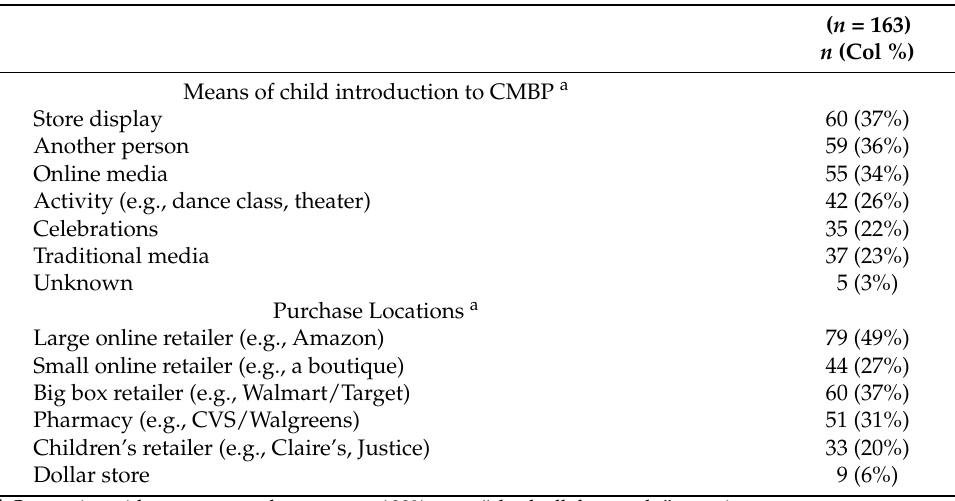
Table 4. Introduction and Purchase Locations.